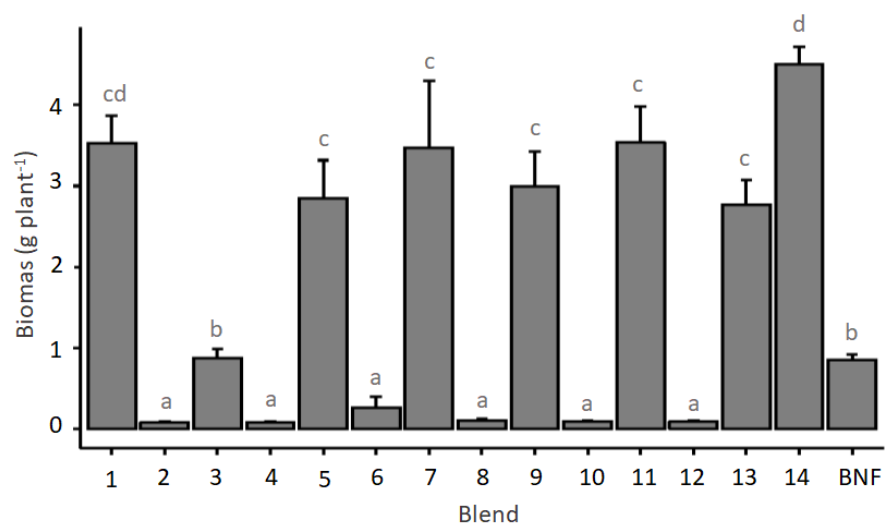
Figure 3. Average biomass (g dry weight) (n = 5) of viola plants for each fertiliser blend. Numbers refer to each specific blend that combines different recovered nutrients applied. Blend 14 is Osmocote ® , a commercial slow-release fertiliser, BNF = blank/control, containing no additional fertiliser. “Different letters (a–d) indicate significant differences ( p < 0.05) between fertilizer blends. Error bar represents the standard error of the mean (n = 5).